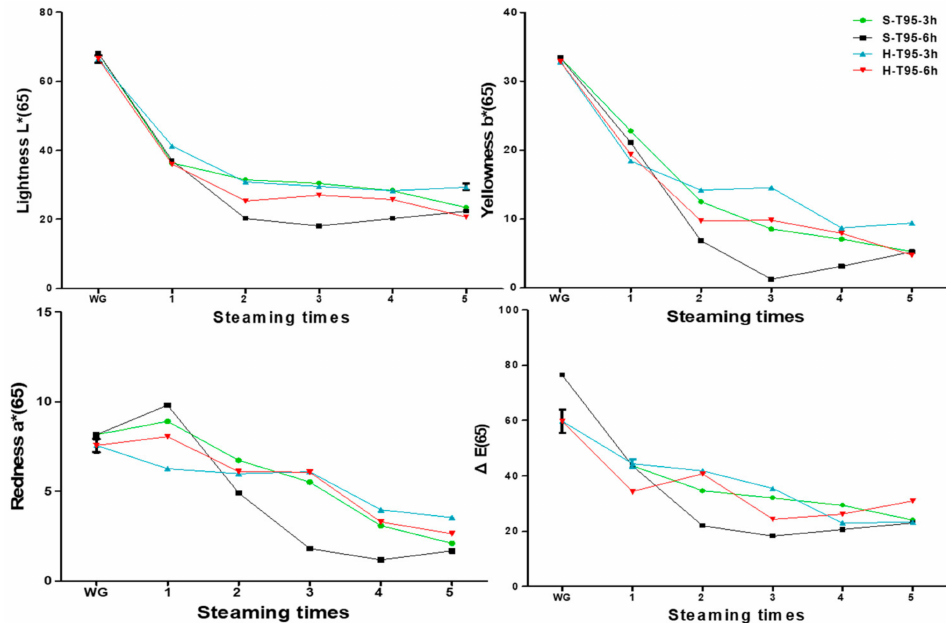
Figure 3. Graph of changes in color between stored and harvested ginseng based on steaming cycles; L*: Lightness; a*: Redness; b*: Yellowness; S: stored ginseng; H: harvested ginseng; T: temperature; h: steaming